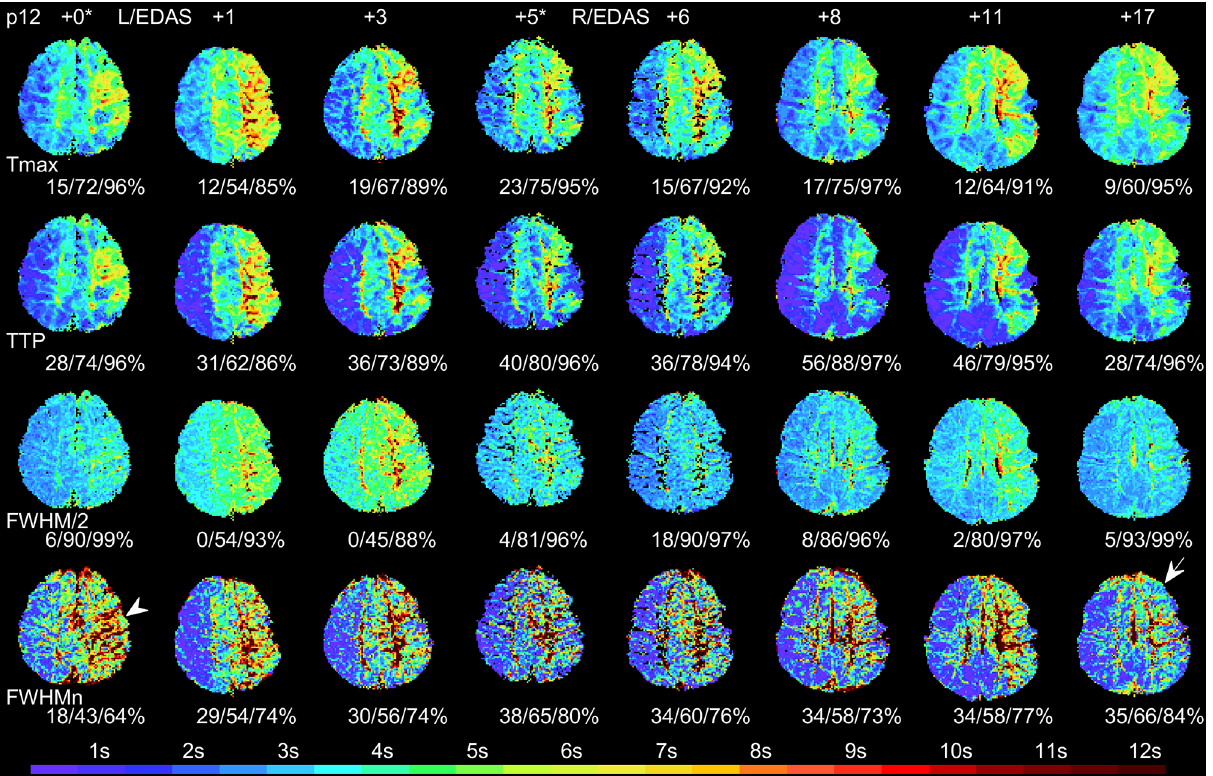
Figure 4. Representative perfusion maps of an 11-year-old boy (patient 12 in Table 1) who underwent a left EDAS operation first and a right EDAS five months later. Normalized delay time areas at thresholds of 2, 4, and 6 s are given under each map. Both Tmax (derived by SVD +M ) and TTP show that perfusion on the left hemisphere improved between months + 5* to + 8 but returned to the pre-surgery condition (+ 0*) after month + 11. However, FWHM n indicates that the contrast time curves on the left hemisphere have become narrower (arrow) compared to pre-surgery (arrow head).